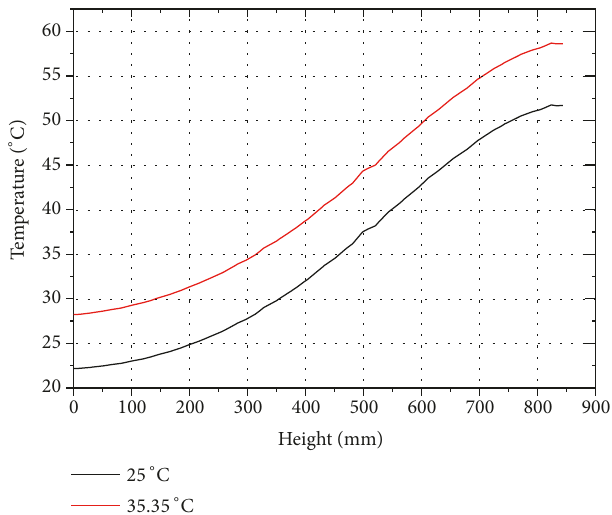
Figure 19: The temperature contrast of front plate between Test B1 and TS1.